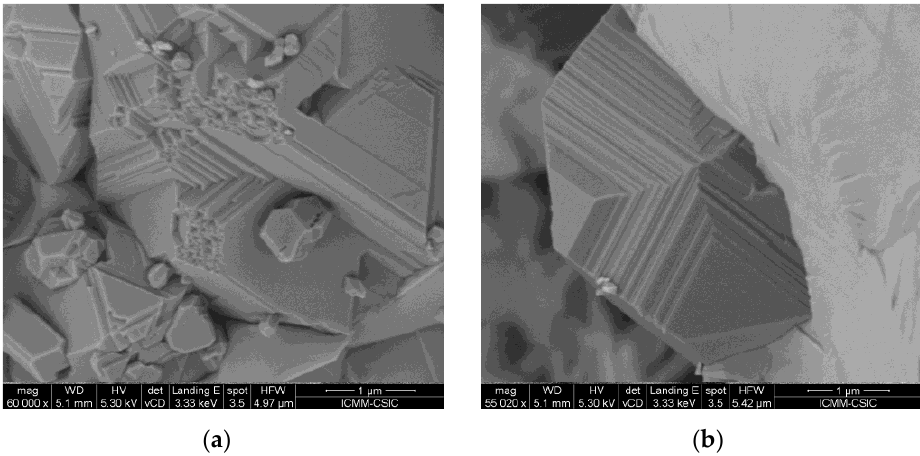
Figure 6. SEM micrographs with ( a ) 60,000× and ( b ) 55,020× magnification, illustrating the nanostructuration in layers observed in this material, grown from arc melting.